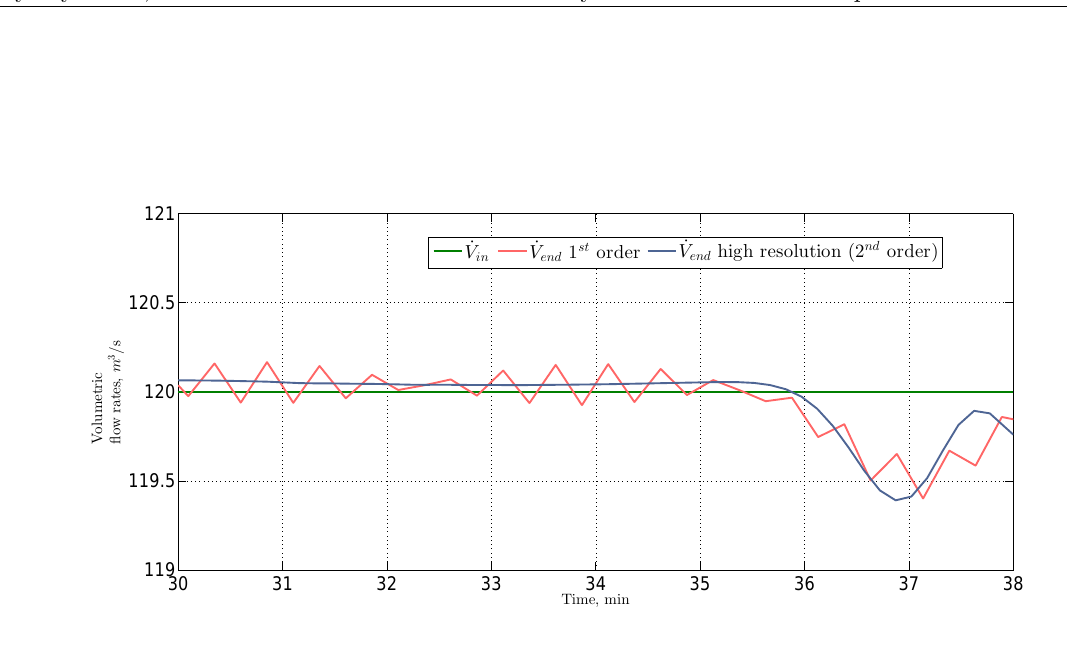
Figure 9: Zoomed plot of the volumetric flow rate in the last cell (ode23t solver).